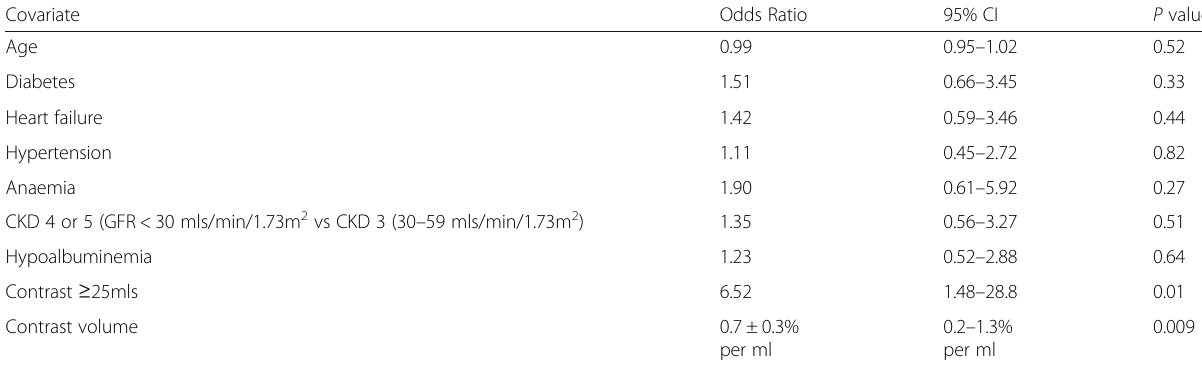
Table 3 Univariate regression analysis of risk modifiers